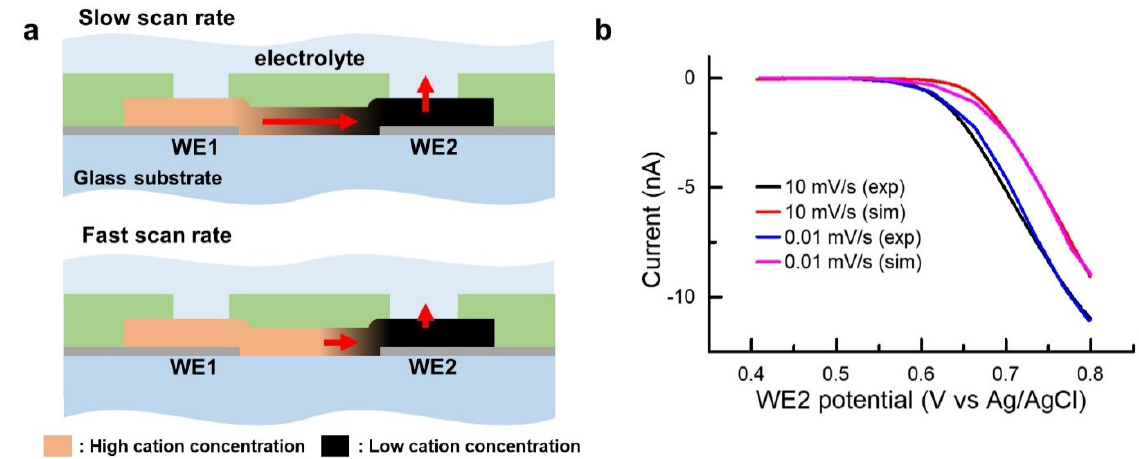
Figure 7. ( a ) Schematic of cation concentration in CuHCFe film under forward scanning of WE2. ( b ) Experimental and simulated currents of WE1 at different scan rates of WE2 (0.01 and 10 mV/s).